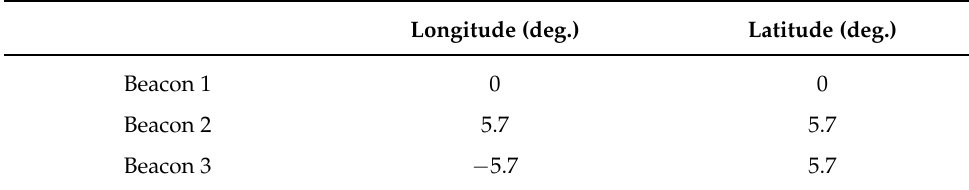
Table 2. UHF transceiver locations on Mars’s surface.